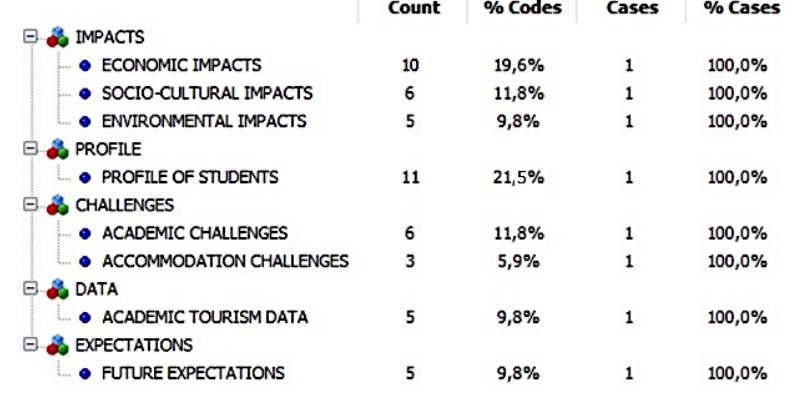
Figure 6: QDA Miner analysis of industry stakeholders’ focus